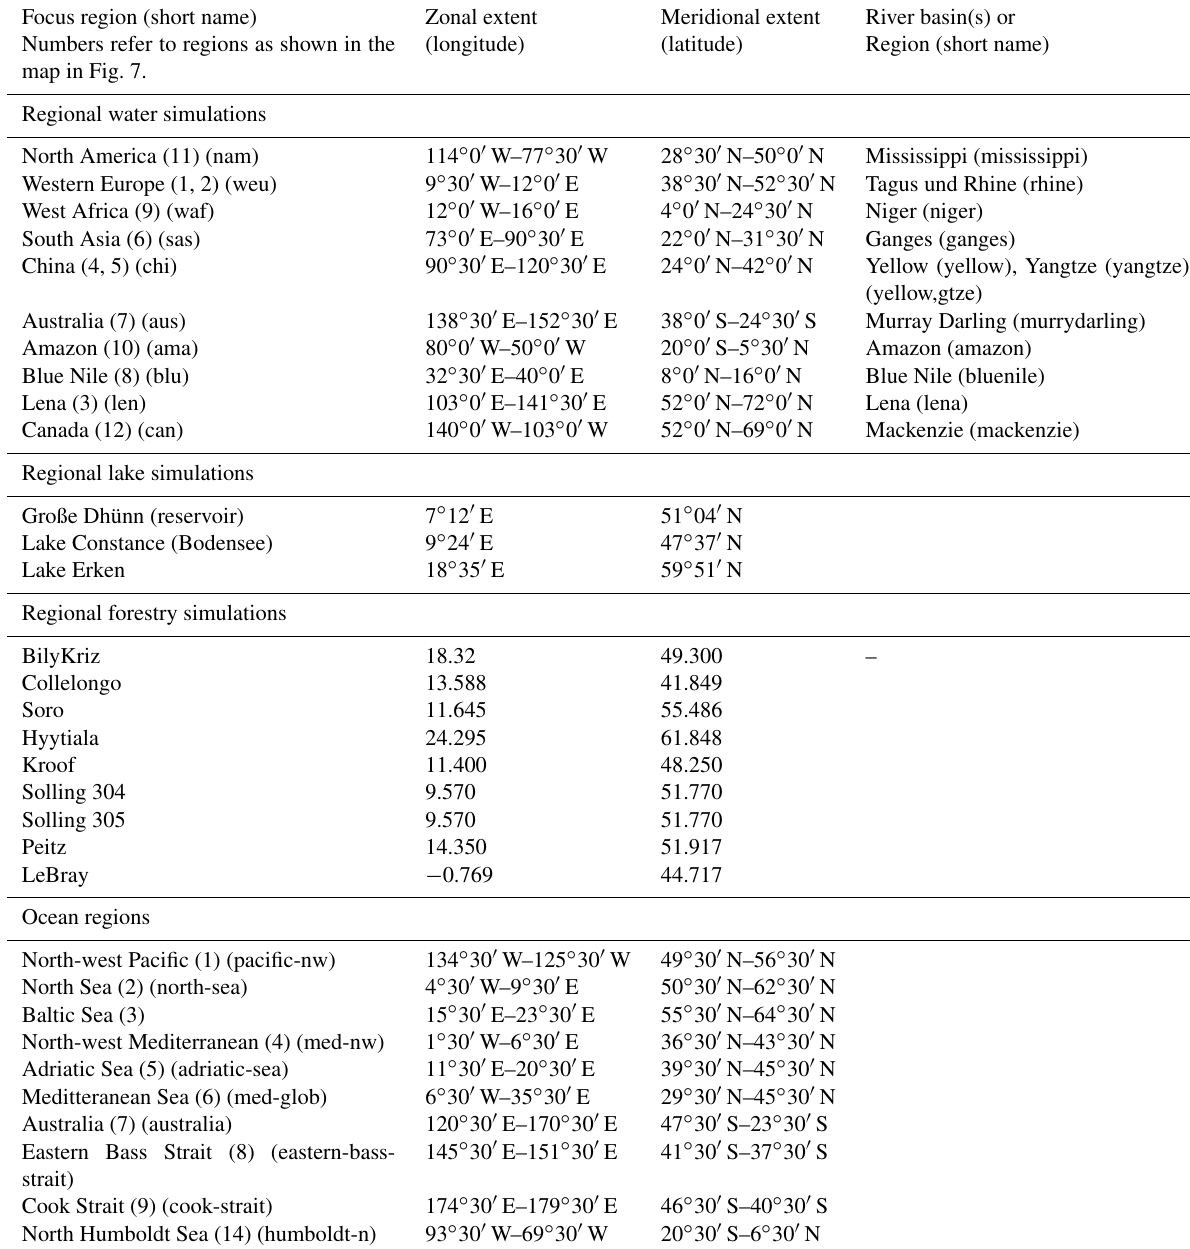
Table 5. List of ISIMIP focus regions as shown in Fig. 7. Focus region (short name) Zonal extent Meridional extent River basin(s) or Numbers refer to regions as shown in the map in Fig. 7.